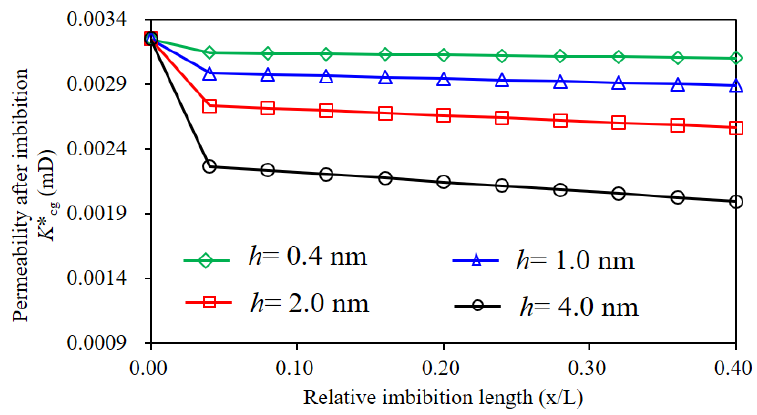
Figure 7. Effect of imbibition on permeability.